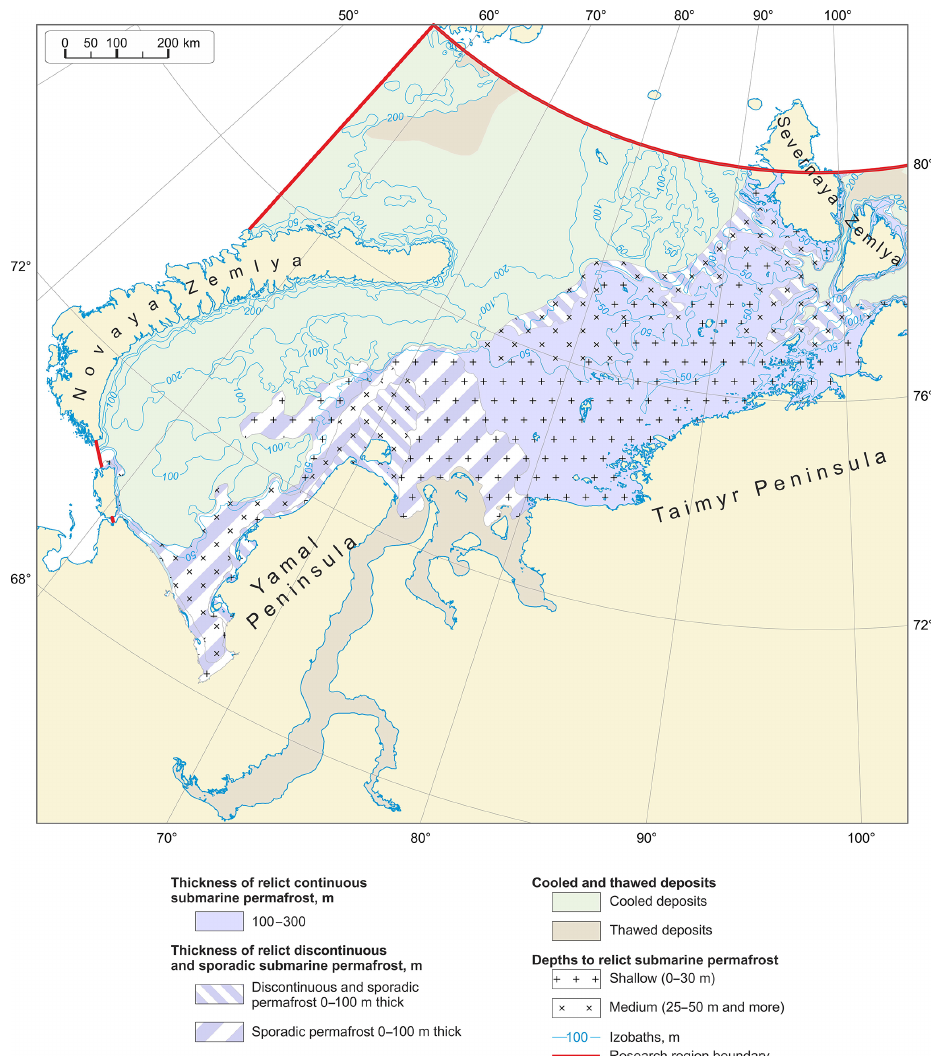
Figure 9. Fragment of the geocryological map of the Kara Sea and its